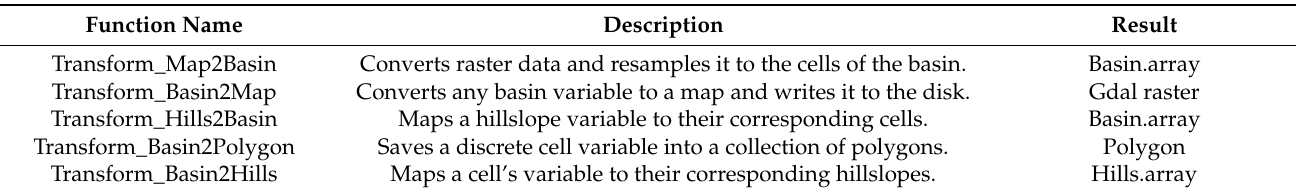
Table 1. Basin class transformation